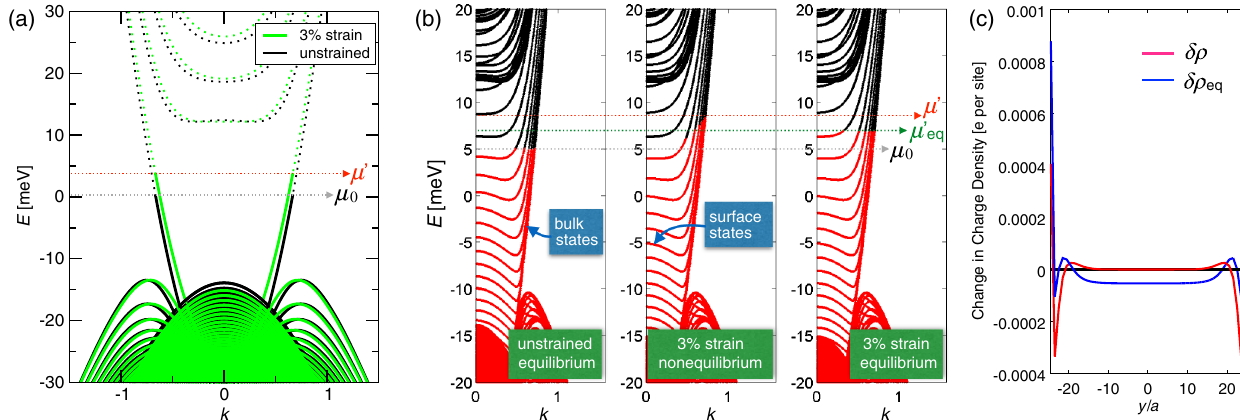
FIG. 4. Tight-binding model simulations of a Weyl semimetal under applied magnetic field B ¼ ˆ zB and unidirectional strain. Parameters for Cd 3 As 2 listed in Appendix A are used in all panels. Only the spin-up sector of the model is considered with B ¼ 10 T. (a) Band structure of the system with periodic boundary conditions in all directions (no surfaces) projected onto the z axis ( k denotes the crystal momentum along the z direction). Solid (dashed) lines show occupied (empty) states. Occupation of the strained system is determined by adiabatically evolving the single-electron states of the unstrained system. (b) Band structure of a slab with thickness d ¼ 1000 Å (50 lattice sites). Only positive values of k are displayed, but the band structure is symmetric about k ¼ 0 . Red (black) lines show occupied (empty) states. The central panel indicates the nonequilibrium occupancy of the strained system obtained by adiabatically evolving the single- electron states of the unstrained system. The right panel shows the occupancy of the strained system once the electrons relax back to equilibrium. All three panels correspond to the same total number of electrons N . (c) Change in the electron density in response to the applied strain as a function of coordinate y perpendicular to the slab surfaces. Here, δρ refers to the nonequilibrium distribution, while δρ refers to the relaxed state. Note that density oscillations near the edges apparent in δρ average to zero: There is no net charge transfer between the bulk and the surface in the nonequilibrium state, as can also be deduced from the vanishing δρ in the